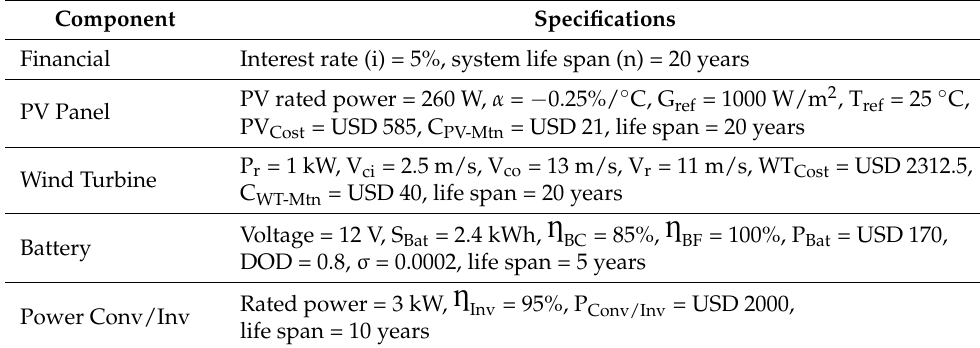
Table 3. Component parameters.